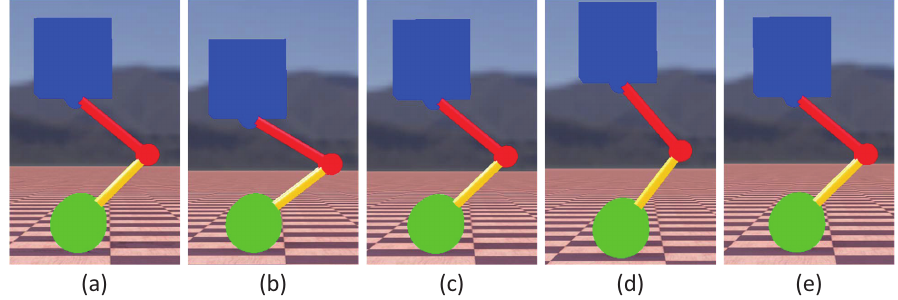
Figure 5. Snapshots of the simulation for the changing height. The standing height of the robot followed a sinusoidal trajectory. The photos ( a , c , e ) correspond to the normal standing height of the robot. Photos ( b , d ) correspond to the bottom and apex of the robot motion process, respectively.